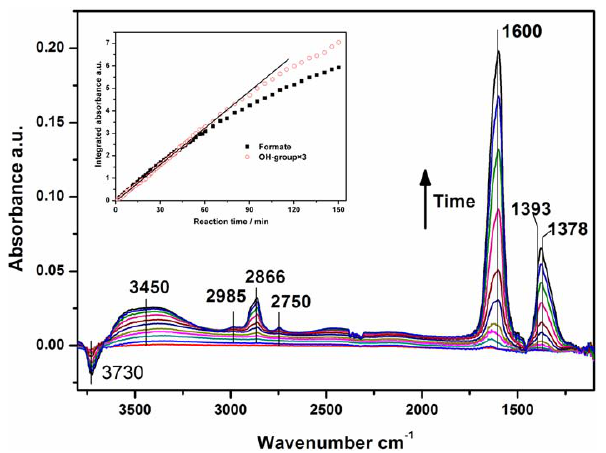
Fig. 2. Absorption spectra recorded during the reaction of CH 3 COOH ([CH 3 COOH] 0 =1.23 × 10 14 moleculescm − 3 ) on α - Al 2 O 3 particles. The inset shows the temporal evolution of the integrated absorbance of the acetate absorption band (1330– 1510cm − 1 ) and the OH absorption band (3600–3800cm − 1 ).